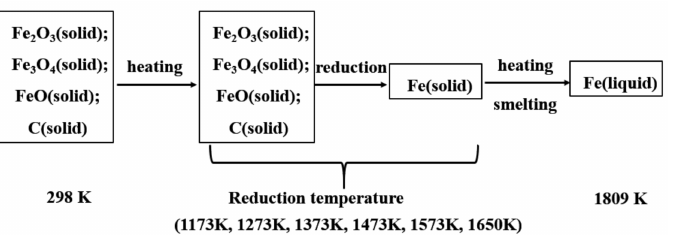
Figure 16. The established flow diagram of the calculation of energy consumption of heating solid materials. Table 6. The energy consumption of heating solid materials per ton iron before smelting (GJ/t). Reaction Equation Coupling